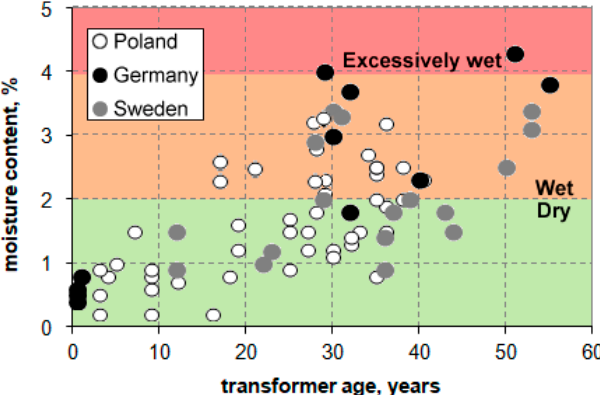
Figure 1. Dependence of water content in cellulose insulation on transformer age in the whole investigated population divided into three moisture ranges as per IEEE classification, on the basis of data from [3].